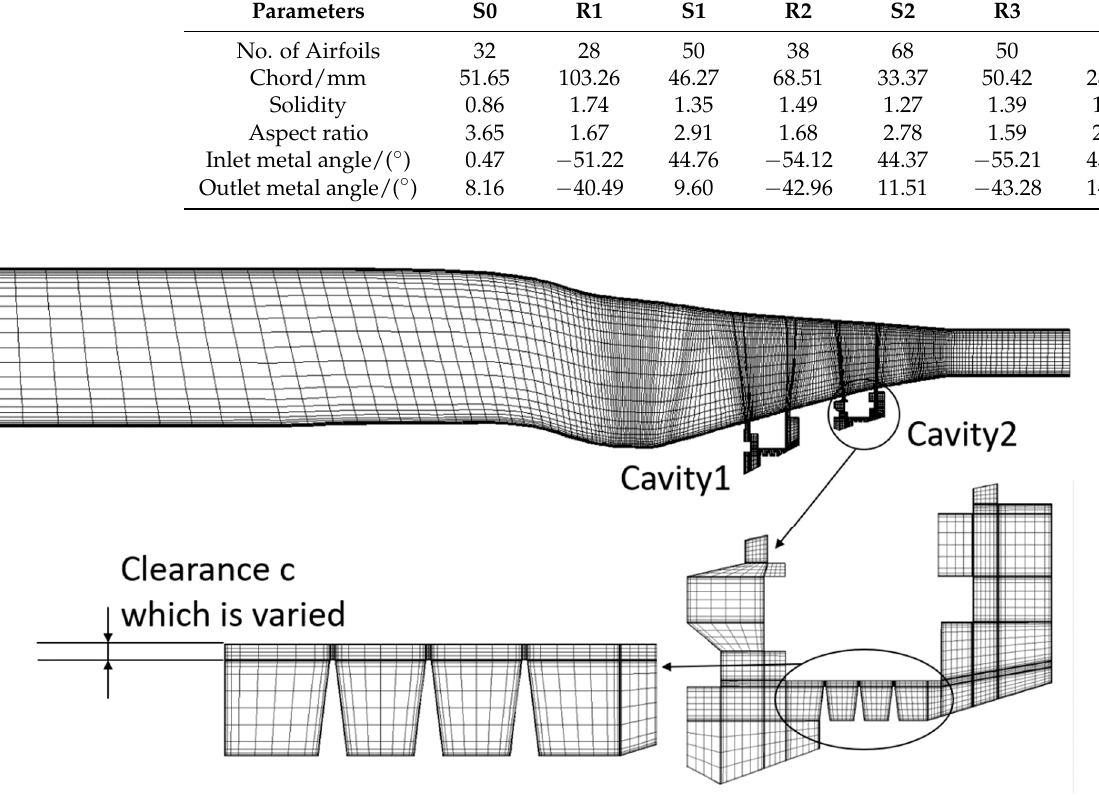
Figure 6. The computational mesh of compressor with seal cavity leakage. Table 2. Clearance values for the different configurations.